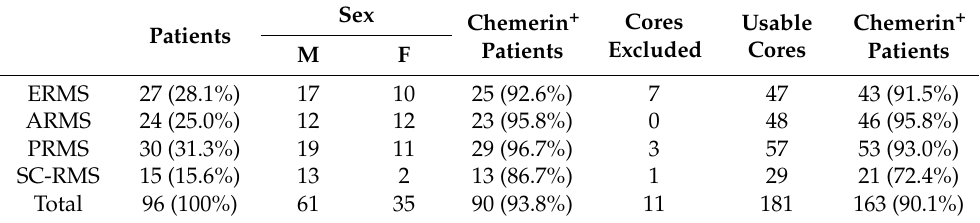
Figure 1. Chemerin expression by RMS. ( A ) Immunohistochemical stain of chemerin on normal skeletal muscle. Size bars represent 50 μ m. ( B ) Immunohistochemical stain of chemerin on an RMS tissue microarray. Shown are 4 cores representing the 4 subtypes of RMS. ERMS (core F10, female, 42 years of age), ARMS (core L4, female 32 years of age), PRMS (core E11, male 67 years of age), SC-RMS (core A10, male 44 years of age). Size bars represent 400 μ m. ( C ) Cells were cultured at 5 × 10 5 /mL for 24 h, and chemerin concentration in supernatant was determined by ELISA. Table 1. Characteristics of patient tissues on the TMA. The column ‘Patients’ states the total number and the percentages of the total patient population for each RMS subtype. The column ‘Chemerin + patients’ states the total number and the percentages of Chemerin + patients per RMS subtype. There were 2 cores for each patient. The column ‘Chemerin + cores’ states the total number and the percentages of Chemerin + cores per RMS subtype. M, Males; F, Females.